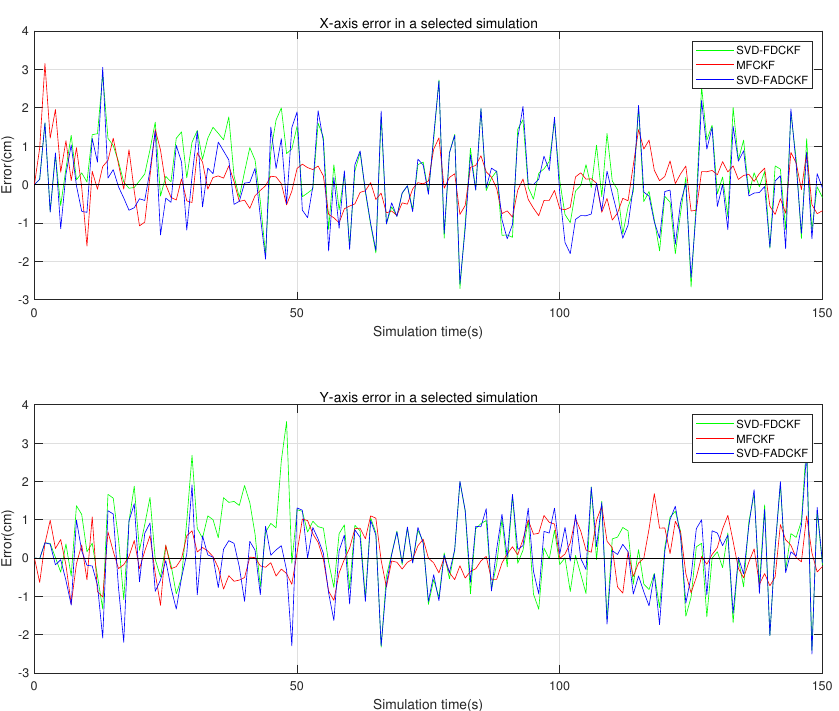
Figure 8. X -axis and Y -axis errors of the three algorithms in selected simulations.